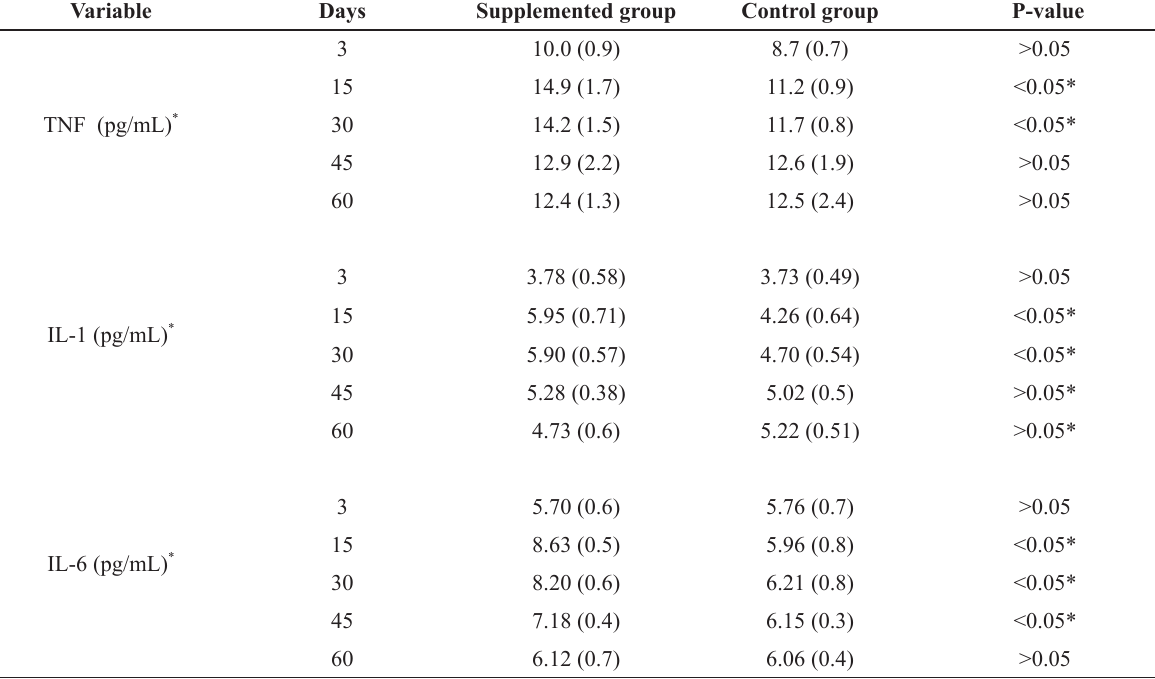
Mean and standard deviation of cytokines (TNF, IL-1 and IL-6) on days 3, 15, 30, 45 and 60 days post-calving of dairy primiparous cows supplemented with injectable minerals during the transitional